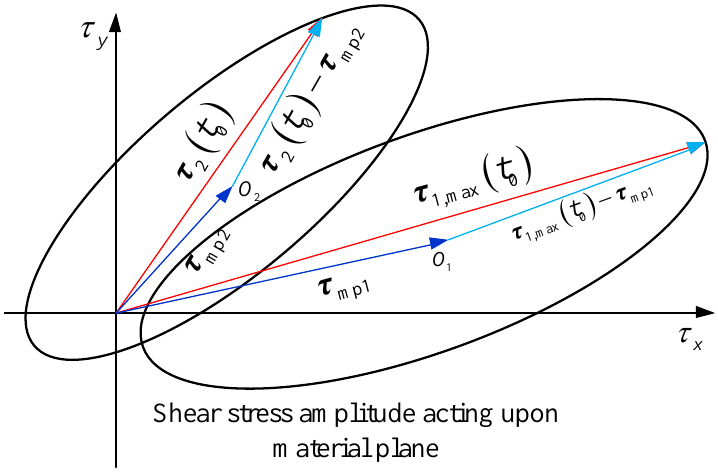
Figure 5. Shear stress amplitude acting upon material plane.